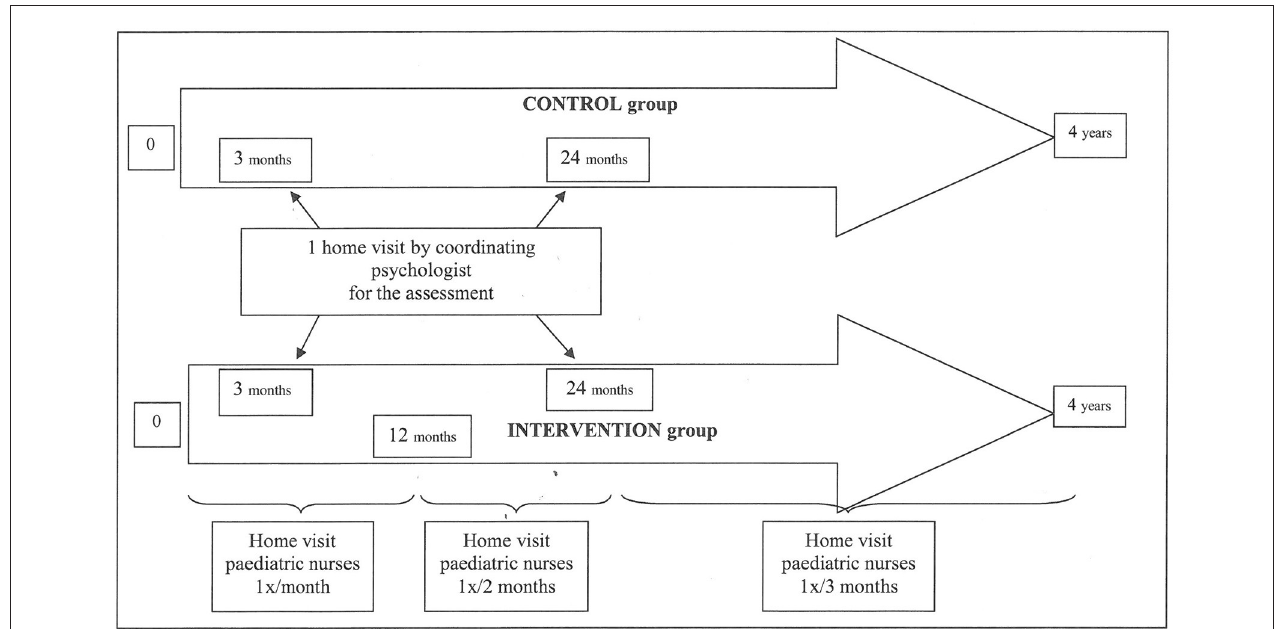
FIGURE 2 | Study design of the PERL